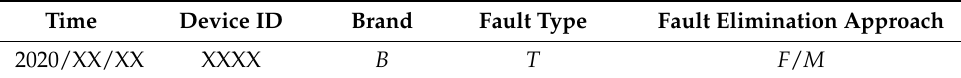
Table 3. DTU fault data